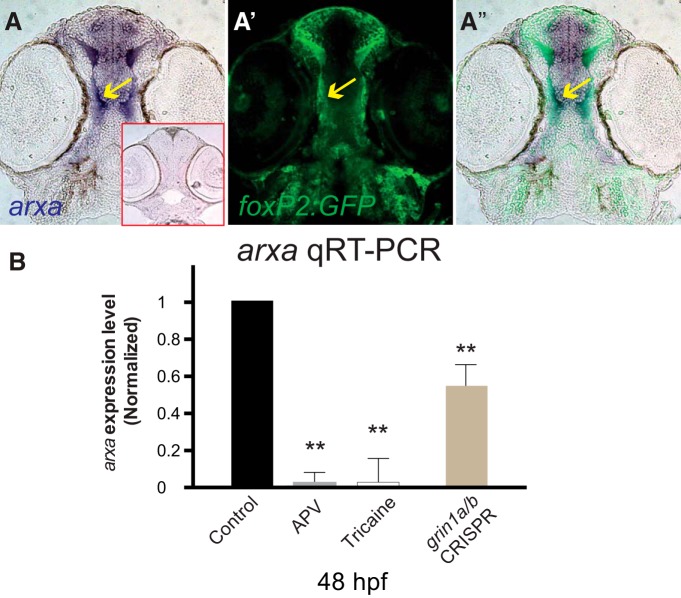
arxa levels are regulated by activity and the NMDAR. A–A’’, foxP2.A.2:egfp-caax and arxa are coexpressed in early development as the TCPT axons extend toward the midline. Sections, rostral top, of arxa in situ expression and Tg(foxP2.A.2:egfp-caax) α-GFP immunohistochemistry. Red boxed inset shows sense probe control for arxa. B, arxa expression is reduced following blockade (APV) or knock-down (CRISPR) of NMDAR or inhibiting activity (tricaine). qRT-PCR at 48 hpf, experimental triplicates; n > 10 embryos each group. Relative log2 fold change calculated relative to wild-type, elf1a standard, SD for each in parenthesis, p values adjusted using Benjamini–Hochberg false discovery rate; **p < 0.01; error bars, SEM.